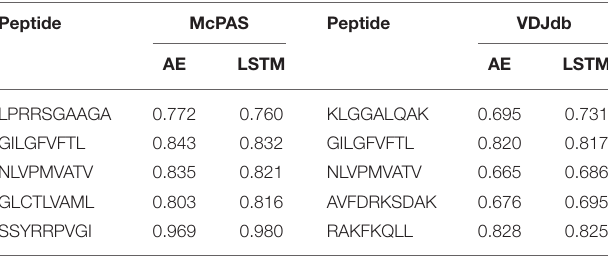
TABLE 1 | Comparison between the different versions of the ERGO classifier [AE (Autoencoder) vs. LSTM and McPAS (23) vs. VDJdb (27)] for the SPB task. Peptide McPAS